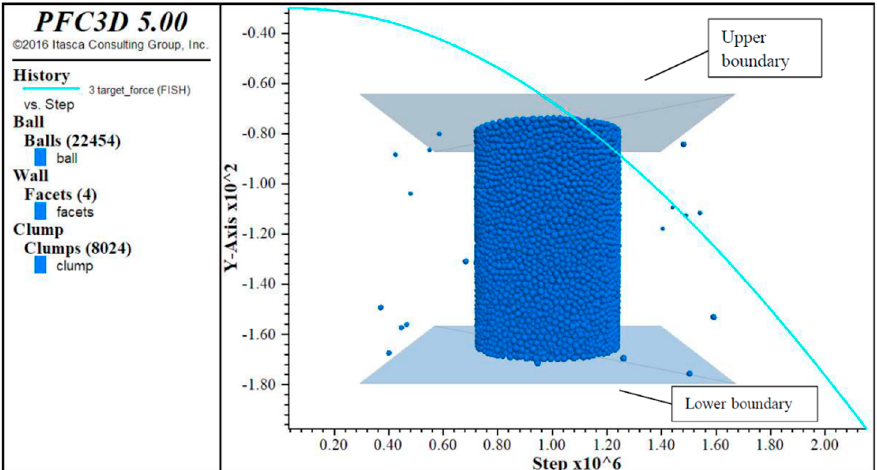
Figure 15. Schematic diagram of loading in the DEM software.